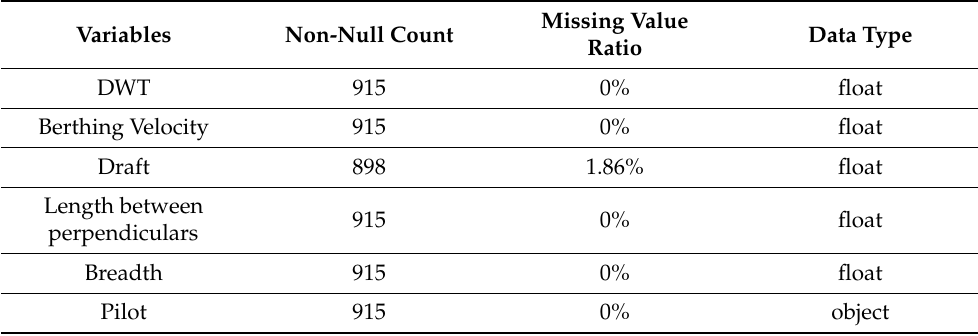
Table 2. The amount of missing values .